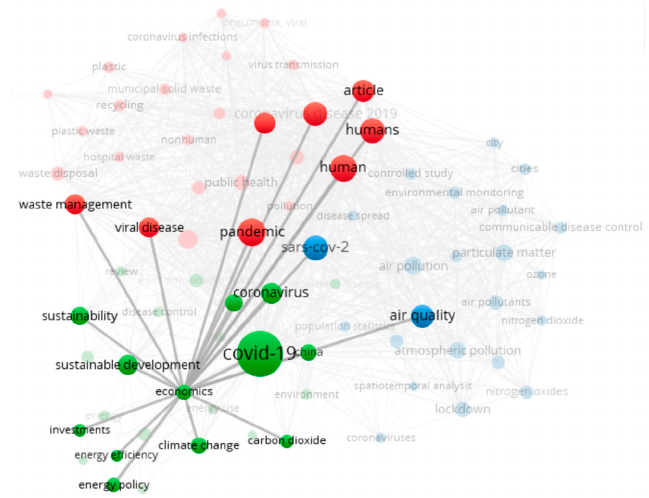
Figure 5. Network map of research topics for the top 10 publications within energy (subject area: renewable energy, sustainability and the environment), 2019–2021. Source: based on the SciVal database (www.scival.com); data source: Scopus (downloaded on 23 June 2021); copyright: Elsevier B.V.